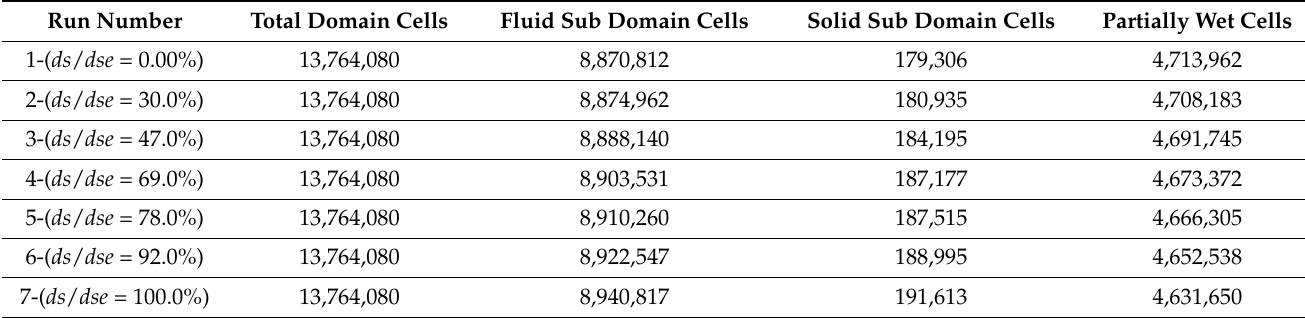
Figure 4. Boundary conditions and generated mesh. Table 1. Variation of the domain cell numbers for the current study